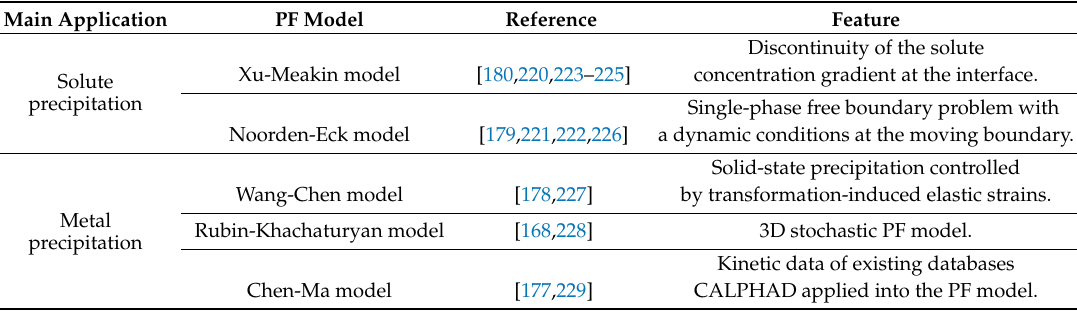
Table 2. PF models for precipitation